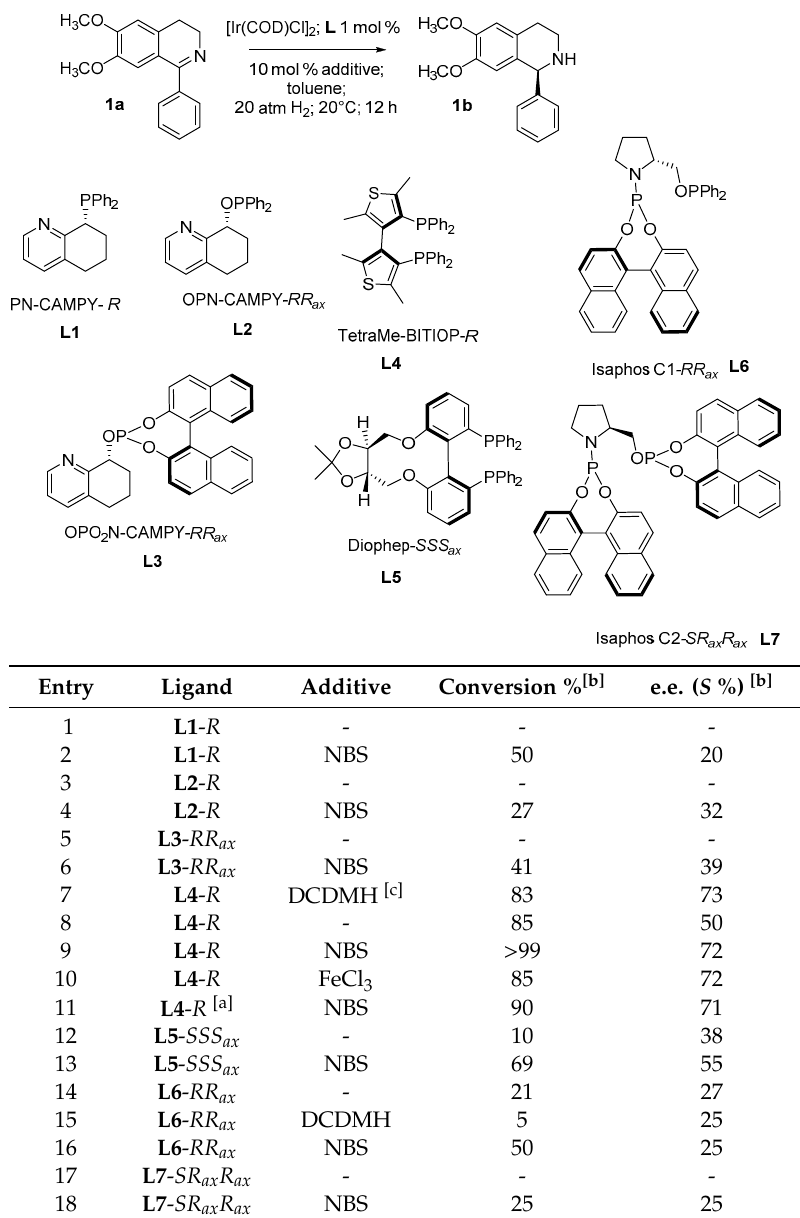
Table 1. Screening of different iridium complexes bearing L1-7 .